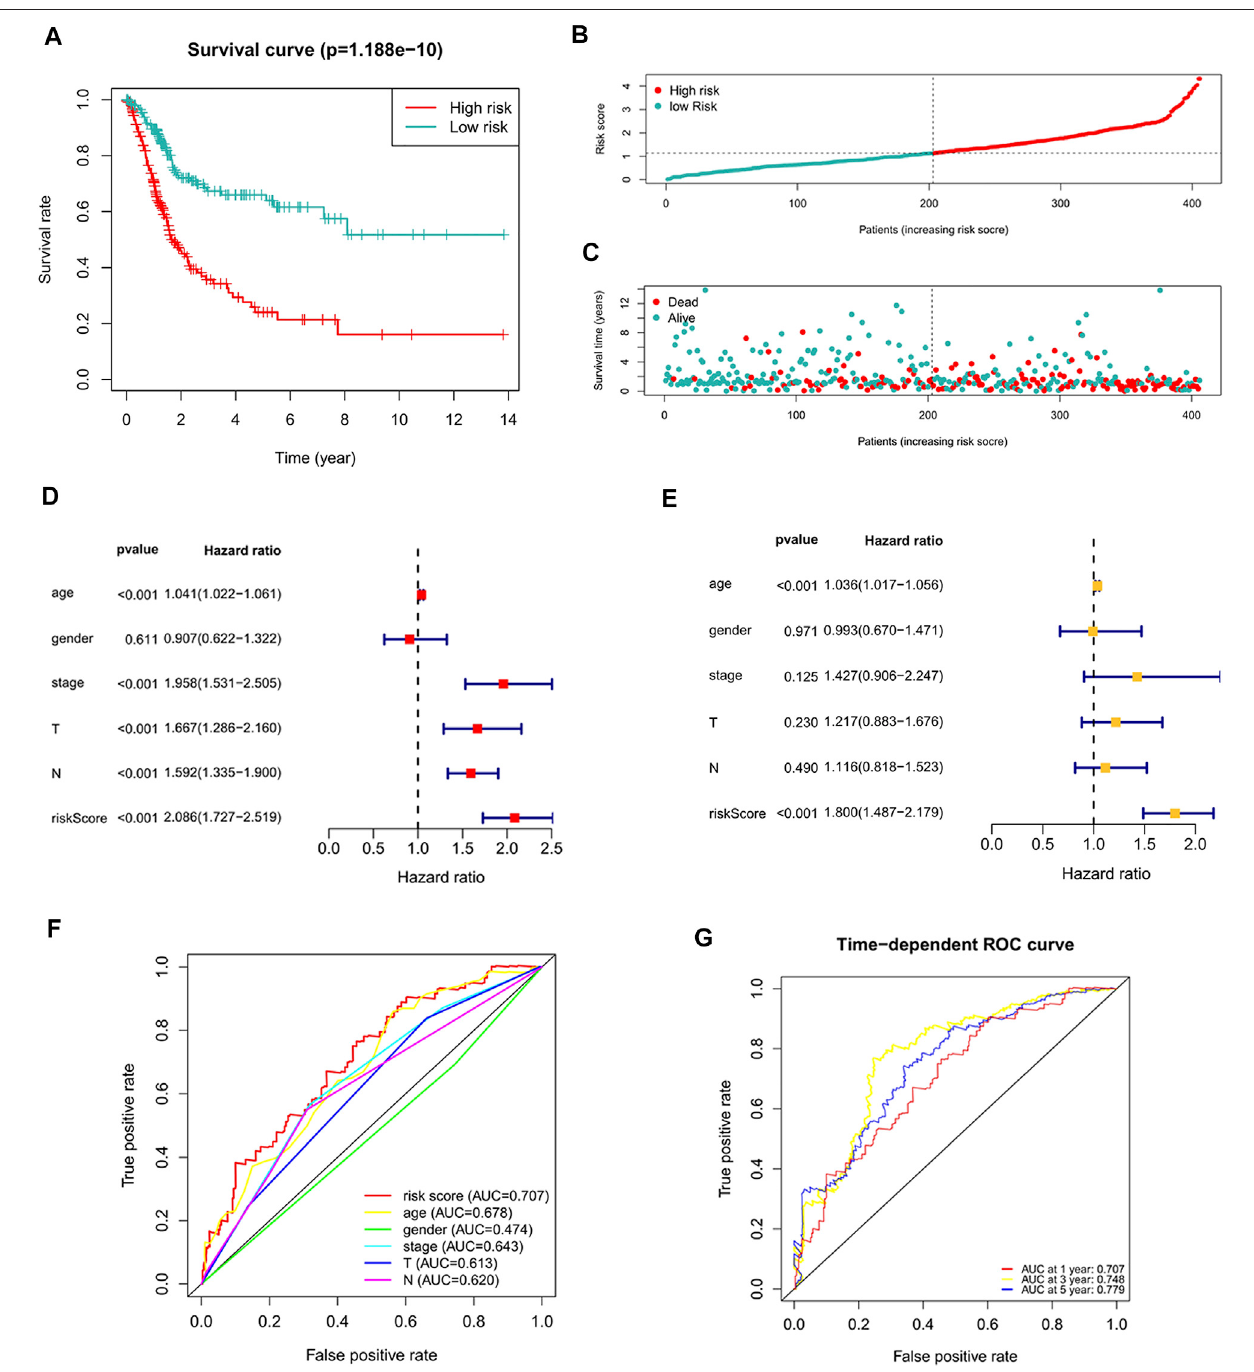
FIGURE4 | The correlation between the predictivesignature and the prognosisofBC patients. (A) Kaplan-Meier analysis ofthe OS rateof BC patients in thehigh- and low-risk groups. (B) The distribution of the risk score among BC patients. (C) The number of dead and alive patients with different risk scores. Blue represents the number of survivors, and red represents the number of deaths. (D) Forest plot for univariate Cox regression analysis. (E) Forest plot for multivariate Cox regression analysis. (F) The ROC curve of the risk score and clinicopathological variables. (G) ROC curve and AUCs at 1-year, 3-years and 5-years survival for the predictive signature. BC, bladder cancer; OS, overall survival; ROC, receiver operating characteristic; AUC, area under the curve; T, tumor; N, lymph node.